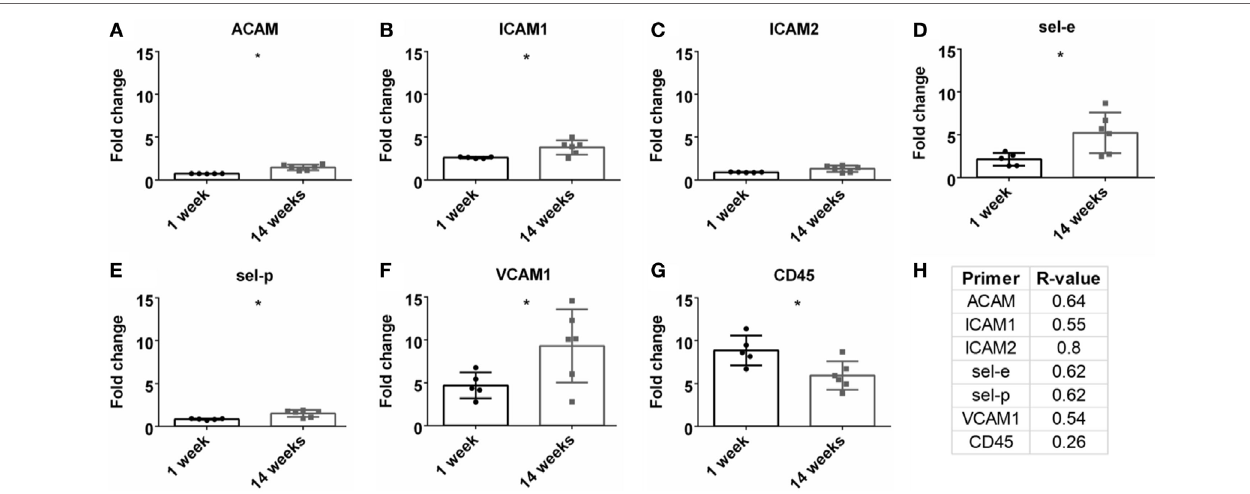
FigUre 6 | Fold change comparisons between 1 and 14 weeks for endothelial adhesion markers (a) ACAM, (b) ICAM1, (c) ICAM2, (D) sel-e, (e) sel-p, (F) VCAM1 and pan-leukocyte marker, (g) CD45 (* p < 0.05, Student’s t -test, Bonferroni corrected). Each time point was compared to age-matched naïve controls to calculate fold change. (h) Pearson correlation for endothelial adhesion and pan-leukocyte markers (* p <